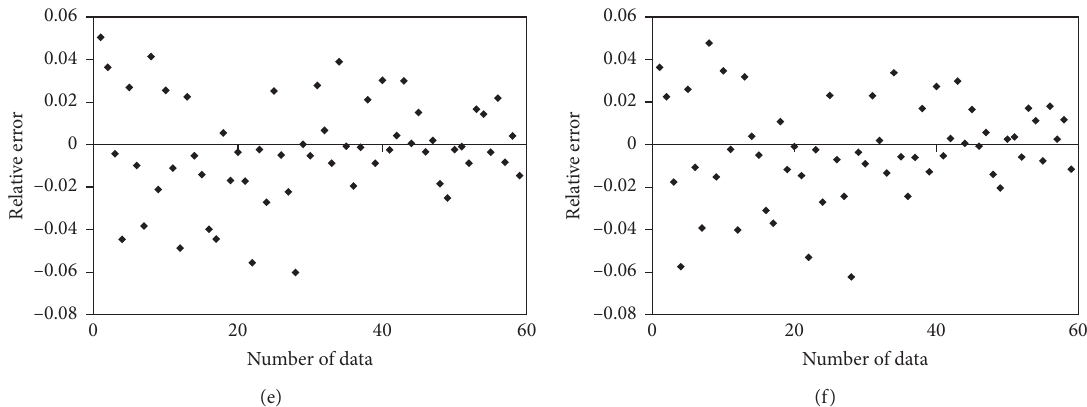
Figure 4: Comparison of relative errors of discharges predicted by different methods for Dataset 2. (a) Conventional method. (b) EA. (c)